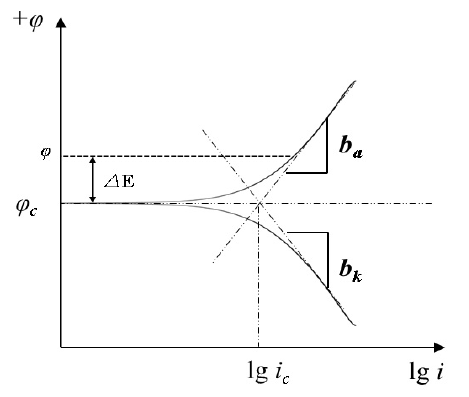
Figure 5. Schematic diagram of the potentiodynamic polarization